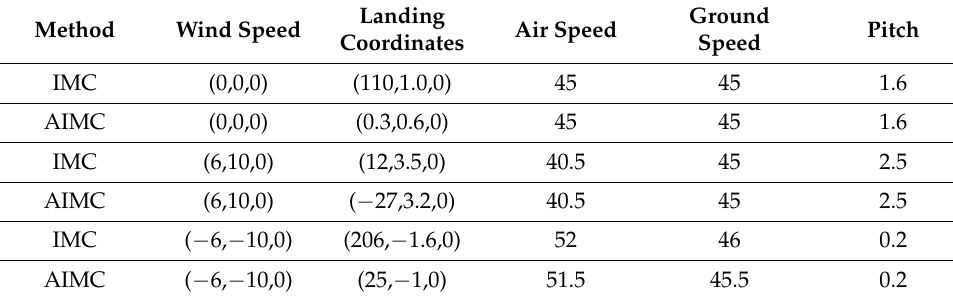
Table 3. State comparison under different